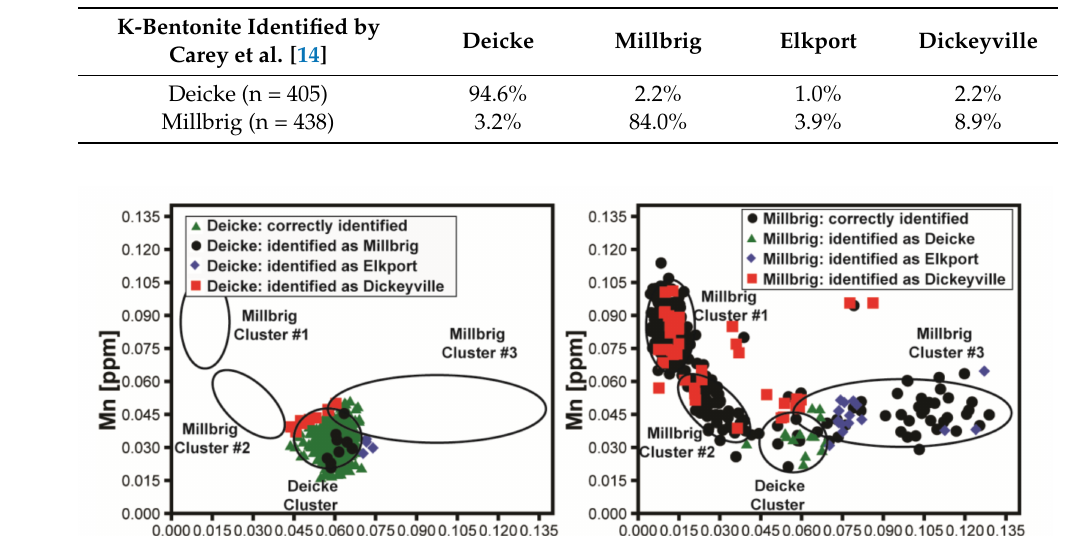
Table 2. Cross-validation results of UMV-model using the Carey et al. [14] dataset. Columns indicate the percentage of identification based on model.